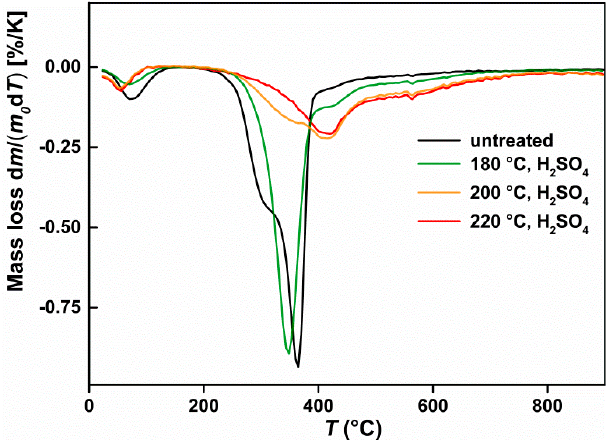
Figure 5. Thermogram (DTG curves) of untreated beech wood and the solid residue after hydrolysis with 0.05 mol L − 1 sulphuric acid at different temperatures.